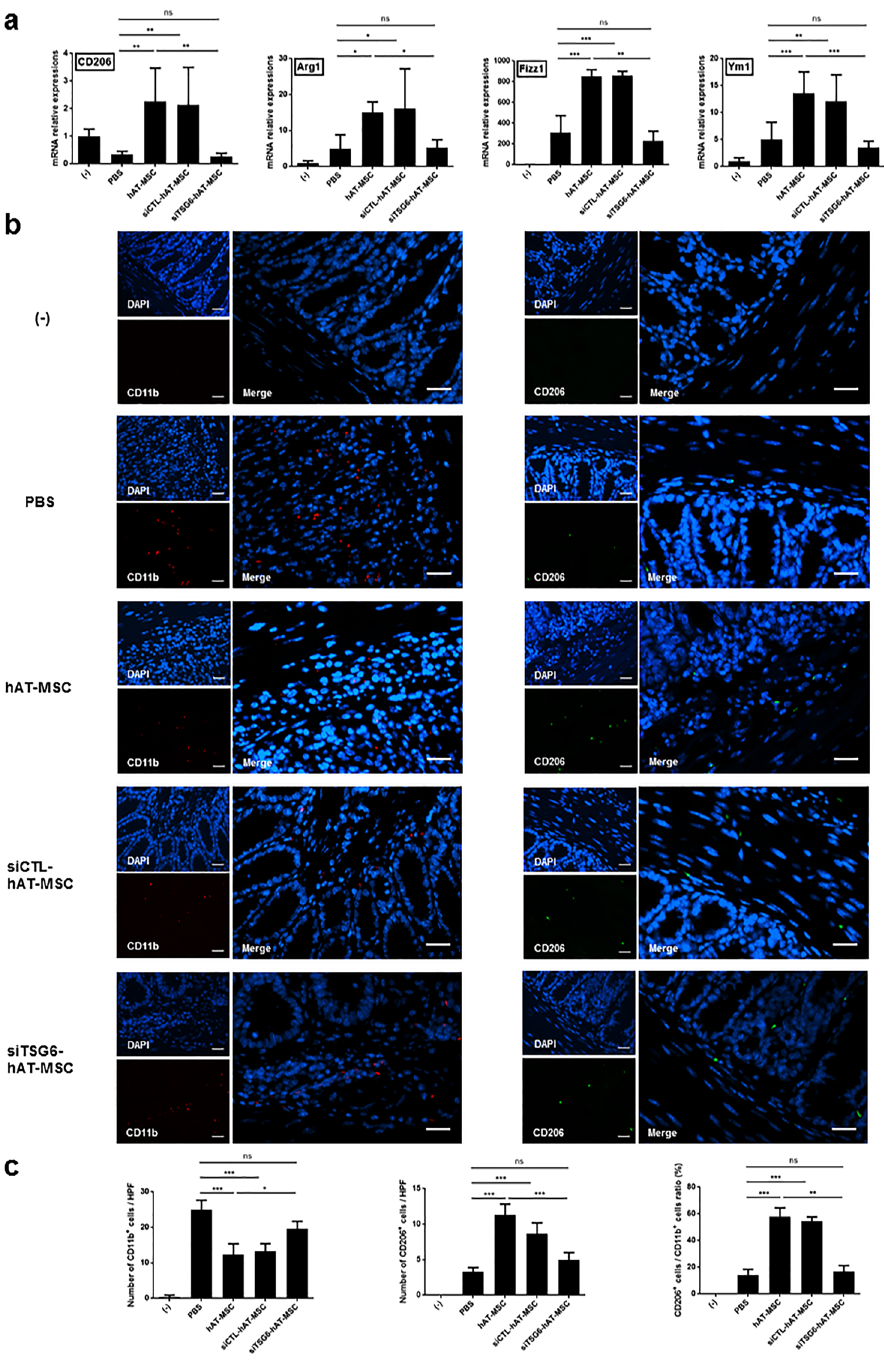
Figure 8. TSG-6 knockdown in hAT-MSCs inhibits their effect on M2 macrophage phenotypic switch. ( a ) The gene expression levels of CD206, Arg1, Fizz1, and Ym1 in the colon samples of mice injected with siTSG6- hAT-MSCs, siCTL-hAT-MSCs, or naïve hAT-MSCs. ( b ) Representative immunofluorescence staining using CD11b- or CD206-specific antibodies. Bars = 30 µ m. ( c ) The number of CD11b- or CD206-positive cells within the inflammatory infiltrates, and the calculated percentage of CD206-positive cells among the CD11b-positive cells. Six to eight mice per group were used. Results are presented as mean ± standard deviation. * P < 0.05, ** P < 0.01, *** P <